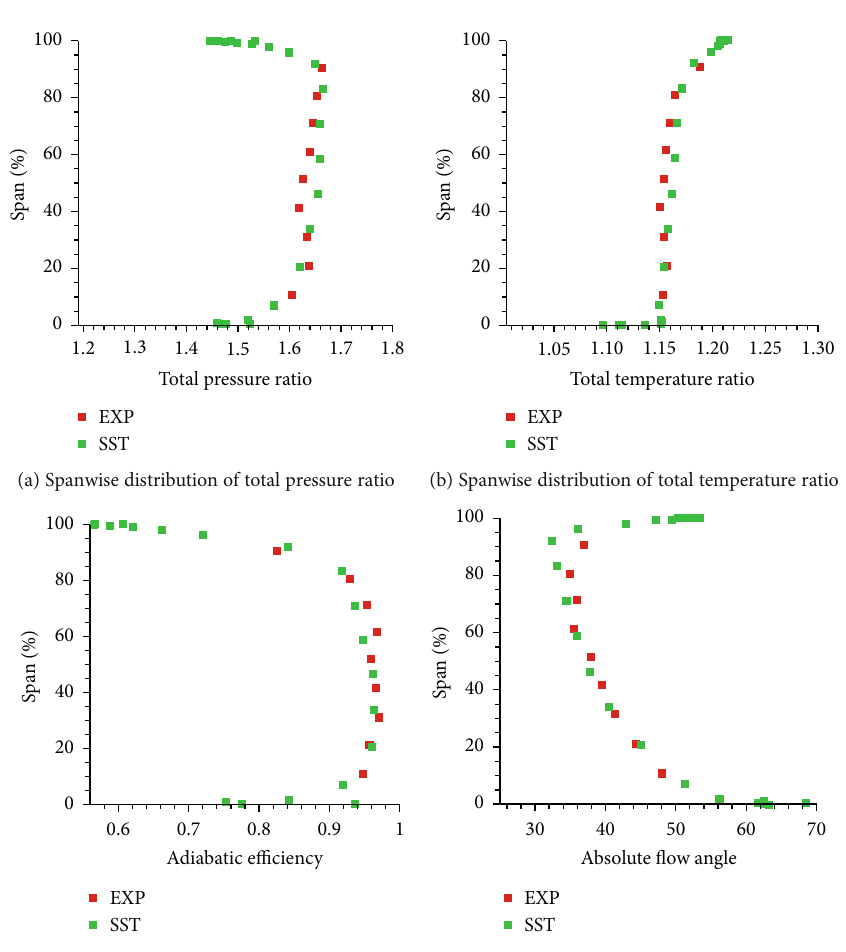
Figure 6: Computational and experimental spanwise distributions of total pressure ratio, total temperature ratio, adiabatic e ffi ciency, and absolute fl ow angle at near-peak e ffi ciency